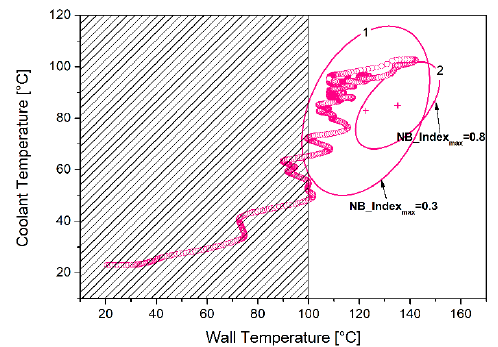
Figure 13. Control region and system trajectory during the NEDC for high boiling levels.